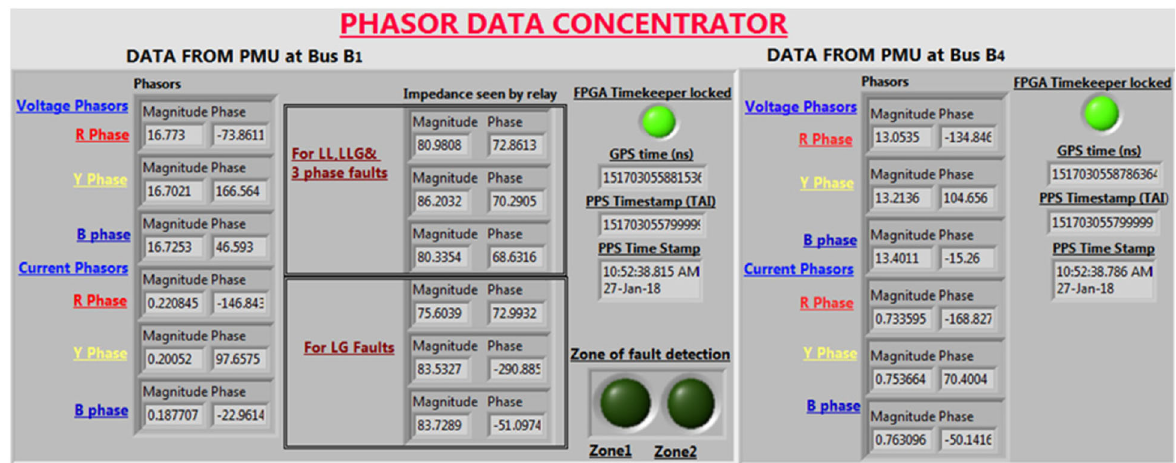
Fig. 12 LabVIEW front panel display of PDC at SPC showing the performance of distance relay R A without the proposed PAZSD methodology for an LLG fault (FR = 4.9 Ω ) at 350 km from B